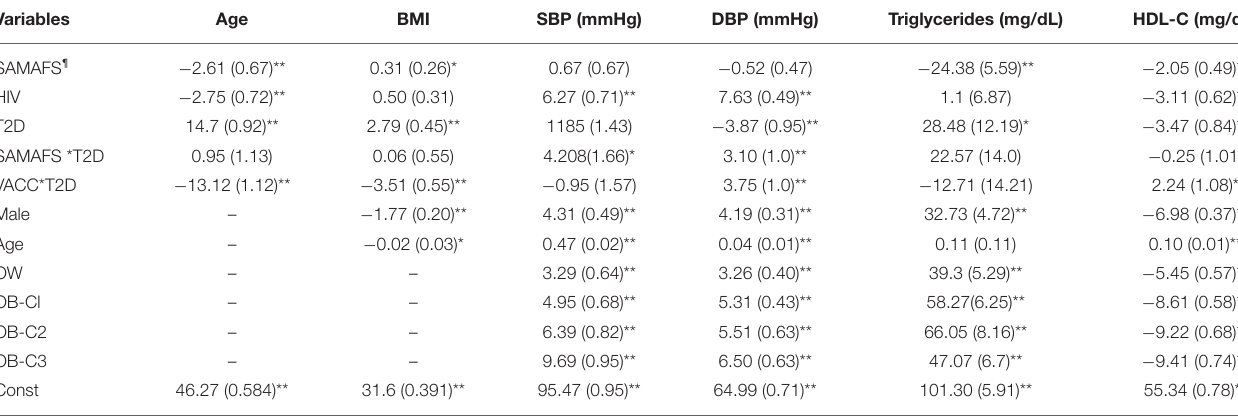
TABLE 7 | General linear models for age, BMI, blood pressure, triglycerides and HDL-C.